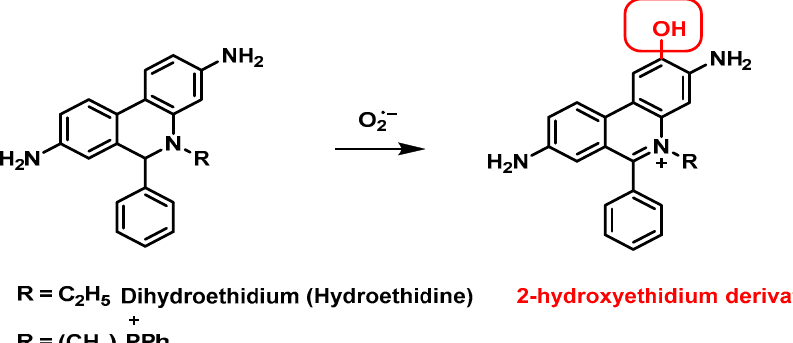
Figure 62. Fluorescent response mechanism of the dihydroethidium (hydroethidine) probe and derivatives to O 2•– .